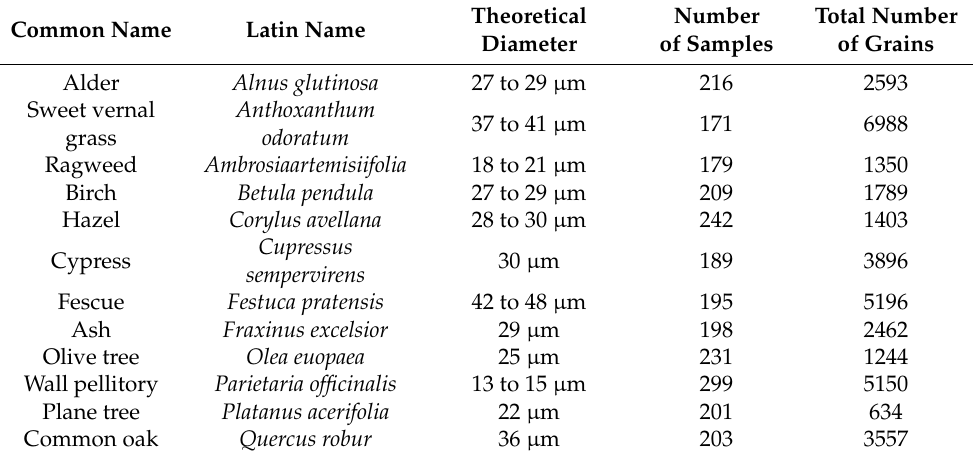
Table 1. List of the pollen species used in the study; the diameters provided by the supplier were determined under microscope at 400 and/or 1000 magnification in the form of either a range or a